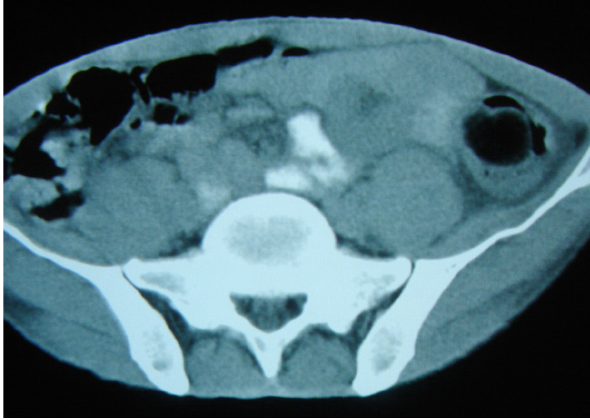
procedure.Figure 1: CT scan showing intussuscepted segment and colonic mass